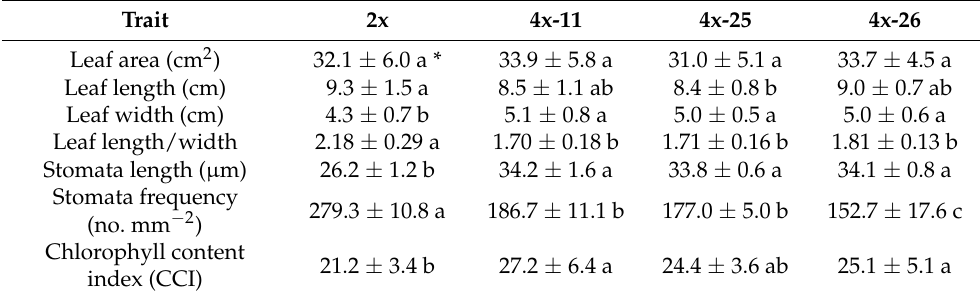
Figure 2. Own-rooted five-year-old diploid (2x) and tetraploid (4x) trees of the apple cv. ‘Redchief’ growing in an experimental orchard at the National Institute of Horticultural Research (Skierniewice, Poland). Table 3. Differences in leaf morphological traits and chlorophyll content between M9-grafted five- year-old trees of diploid (2x) and tetraploid clones 4x-11, 4x-25, and 4x-26 of the apple cv. ‘Redchief’.